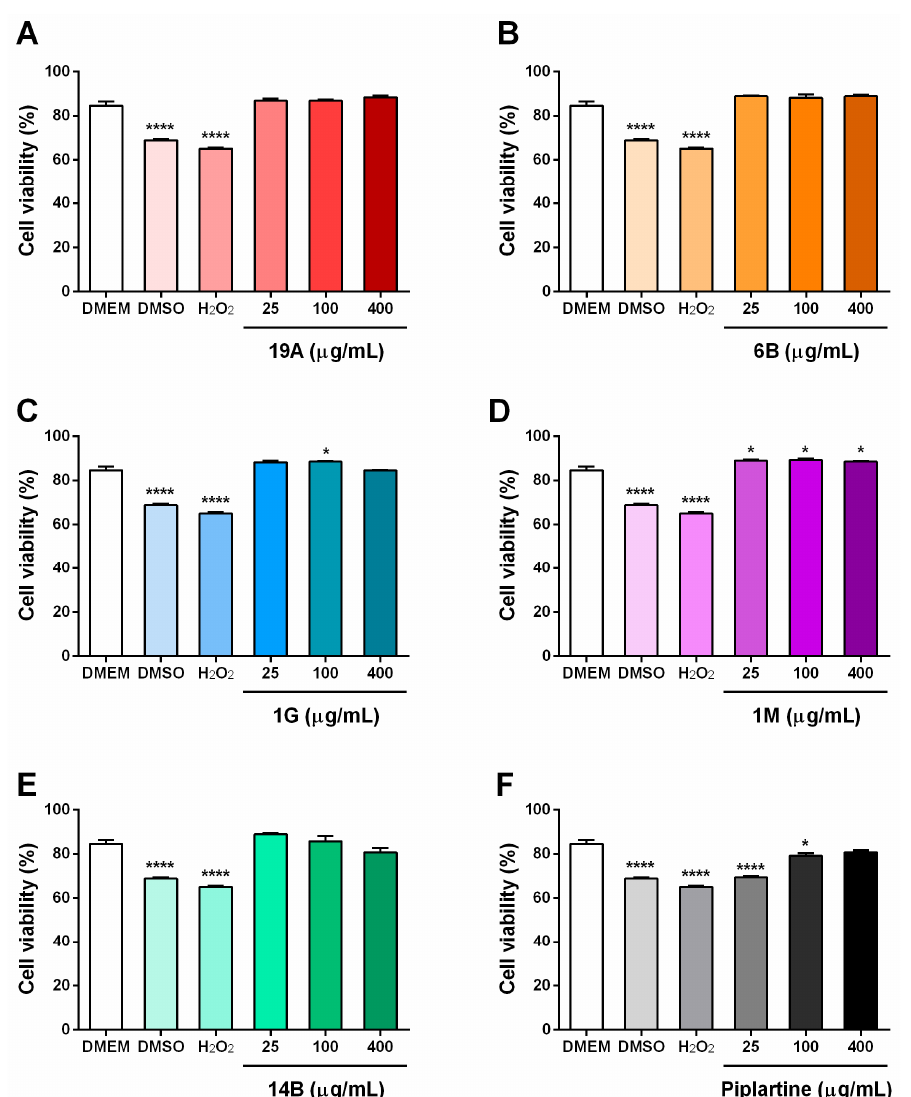
Figure 4. Cytotoxicity evaluation in the mouse BALB/cN macrophage (J774A.1) cell line following exposure for 24 h to piplartine analogues ( A ) 19A (72, 291 and 1165 µM), ( B ) 6B (62, 249 and 999 µM), ( C ) 1G (85, 342 and 1369 µM), ( D ) 1M (56, 224 and 898 µM), ( E ) 14B (101, 406 and 1625 µM) and ( F ) piplartine (78, 314 and 1257 µM). Molecules were used at the same concentrations range at µg/mL for all samples (25, 100 and 400). Dulbecco's Modified Eagle Medium (DMEM) was used as a negative control. Cells were analysed by flow cytometry (20,000 events/sample). The values are expressed as mean ± SEM. * p < 0.05 and **** p < 0.0001 vs. DMEM control group.